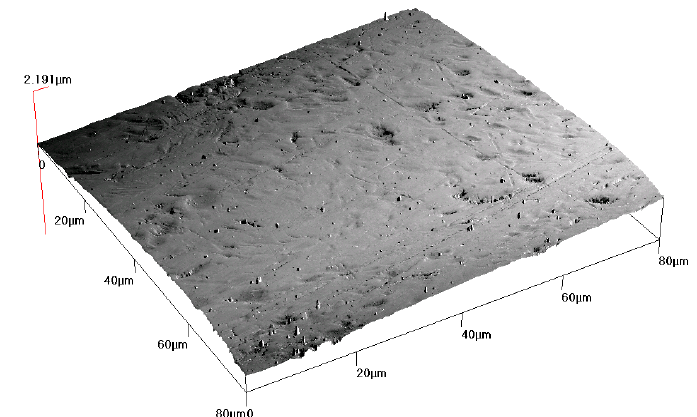
Figure 20. AFM inspection to observe the surface irregularities.